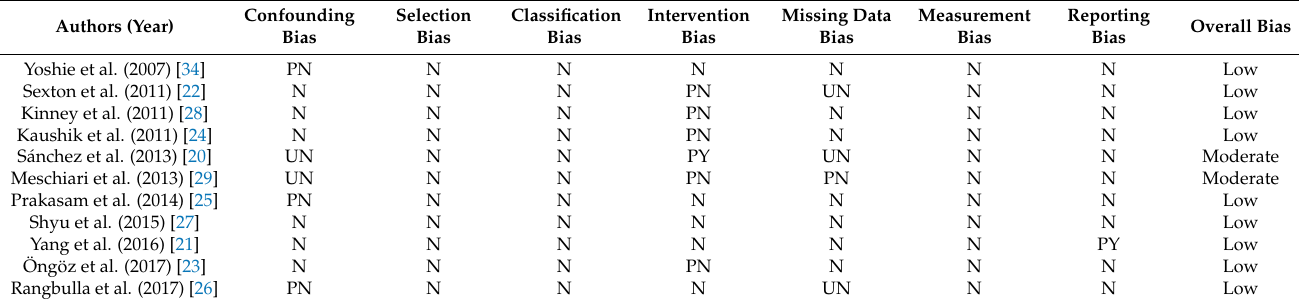
Table 3. Quality assessment of the included studies (ROBINS-I tool).